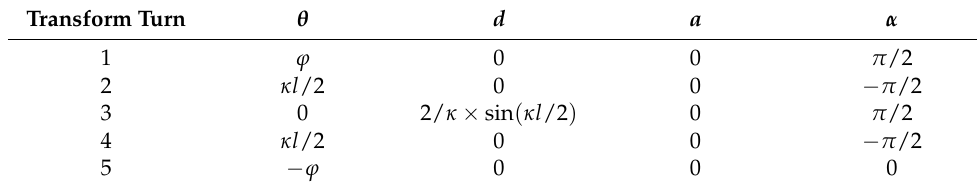
Table 1. Single CKM D–H matrix.